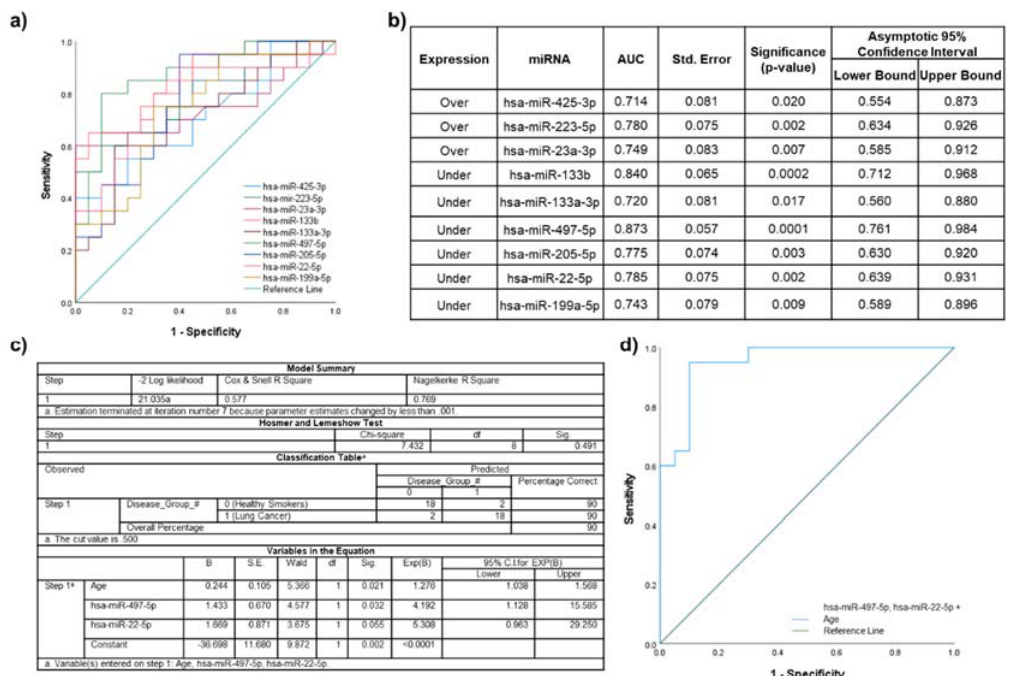
Figure 5. Discriminatory power assessed using ROC curves for the miRNAs that were significantly dysregulated in lung cancer participants compared to healthy smokers. ( a ) Individual ROC curves for under- and overexpressed miRNAs; ( b ) AUC values, including standard error (Std. Error), significance and 95% confidence intervals; ( c ) binary logistic regression model for miR-497-5p, miR-22-5p and significant clinical characteristics (age); and ( d ) ROC curve for the logistic regression model.